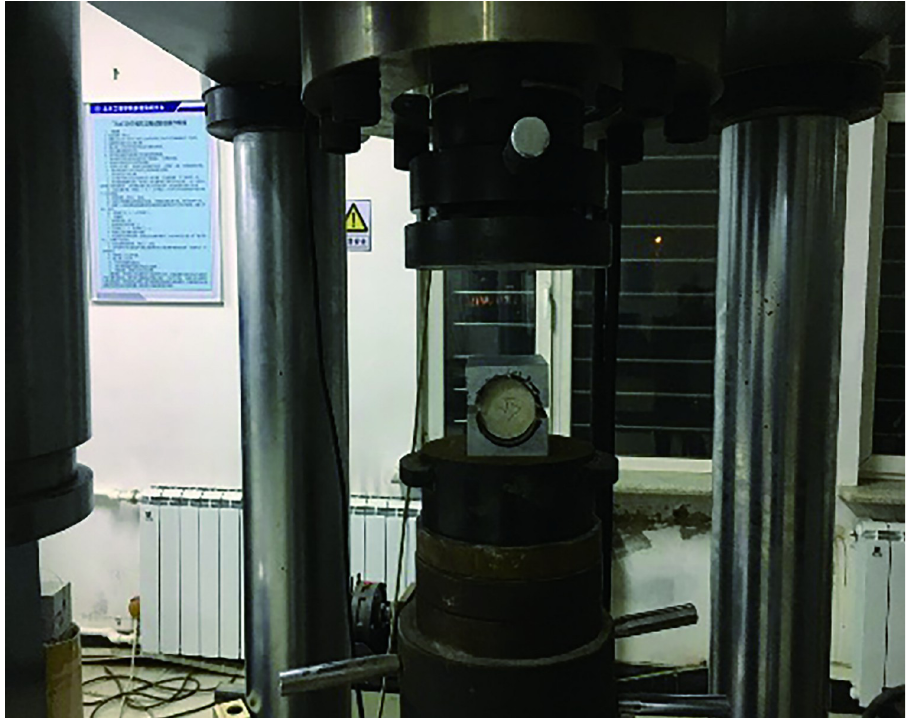
Fig 4. Tensile strength test for rockburst-like materials.